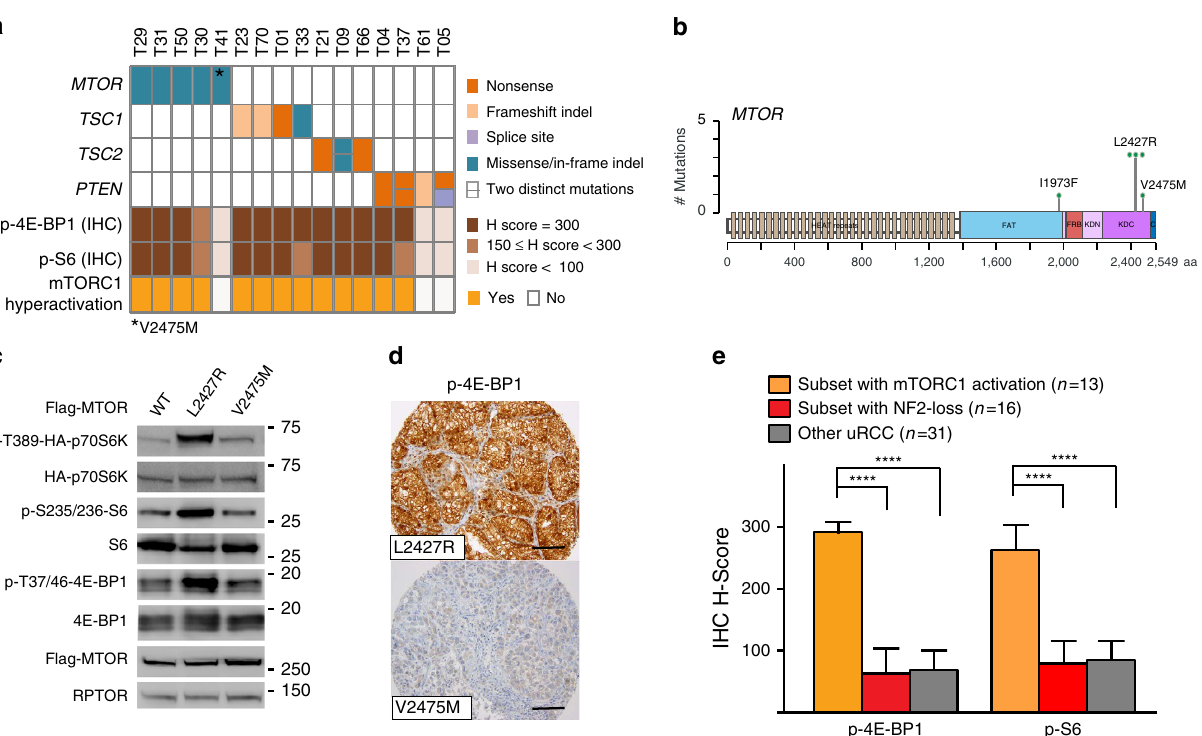
Figure 3 | uRCC subset with hyperactive mTORC1 signalling. ( a ) Schematic overview of indicated mutational and immunohistochemical analyses with annotation of mTORC1 hyperactivation on a subset of uRCC ( n ¼ 16). ( b ) Depiction of MTOR missense mutations identified in 5 (8%) uRCC tumours. MTOR L2427R mutation recurred in three individual tumours. ( c ) Functional analyses of MTOR L2427R and V2475M mutants. 293Tcells were transfected with the indicated Flag-tagged MTOR expression constructs in conjunction with HA-S6K. Cellular extracts were collected 48h later and probed with the indicated antibodies. ( d ) Representative images of p-4EBP1 immunostaining in L2427R and V2475M MTOR mutant tumours. Scale bars, 100 m m. ( e ) Immunostaining scores (H-scores) of p-4EBP1 and p-S6 were determined and presented as a bar graph on mTORC1 hypearctivation ( n ¼ 13), NF2 loss ( n ¼ 16) or the other uRCC ( n ¼ 31) tumours. H-Scores (H ¼ intensity (0–3) (cid:2) percentage of positive cells (1–100)). Bars, mean values; error bars, 95%